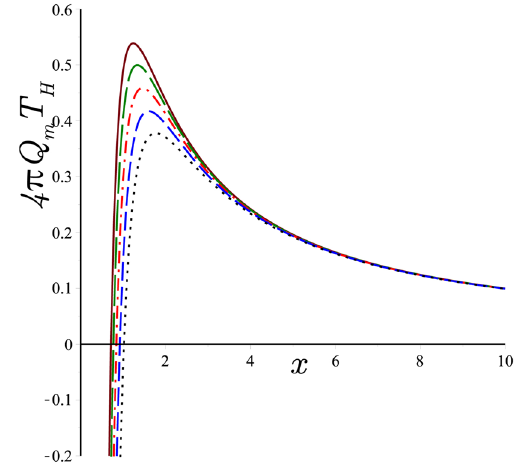
Fig. 2 The Hawking temperature 4 π Q m T H in terms of x = r h γ = 0 . 0000 to γ = tanh − 1 (cid:6) (cid:5) Q e = 0 . and Q m